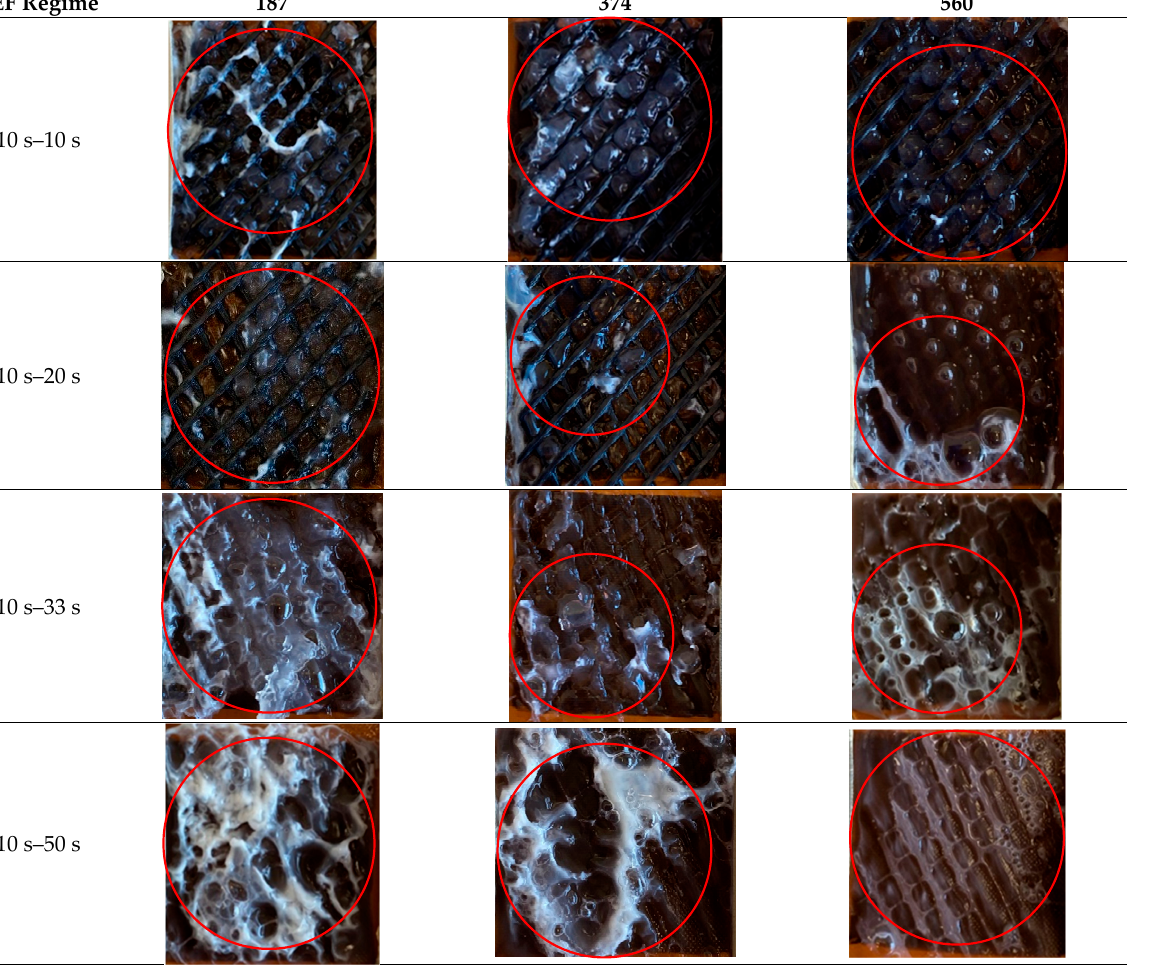
Figure 5. Photographs of the BPM cationic surface in contact with caseinate after EDBM in PEF mode carried out at different flow rates (corresponding to indicated Reynolds numbers) and different pause durations. Reynolds numbers of 187, 374 and 560 correspond to linear velocities of 7.8, 15.6 and 23.4 cm/s, respectively. The red circles indicate areas with the highest amount of deposit.